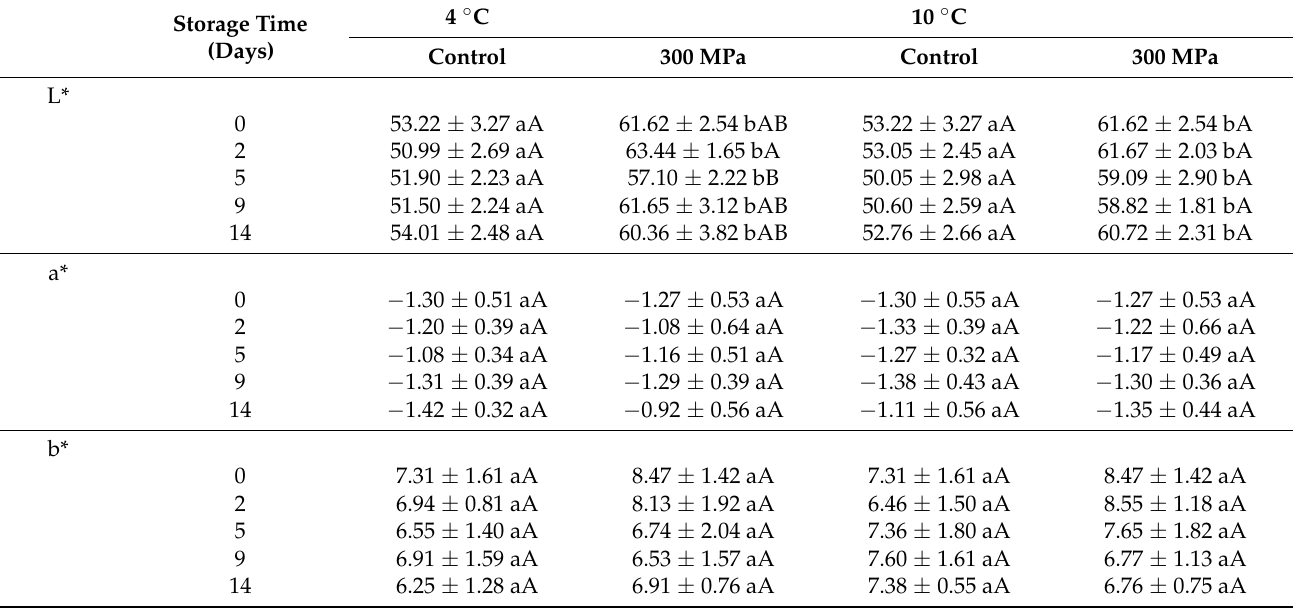
Table 3. L*, a* and b* values obtained for untreated (control) and HPP oysters (300 MPa for 2 min) over 14 days of storage (sampling points: 0, 2, 5, 9 and 14 days) and at different storage temperatures (4 and 10 ◦